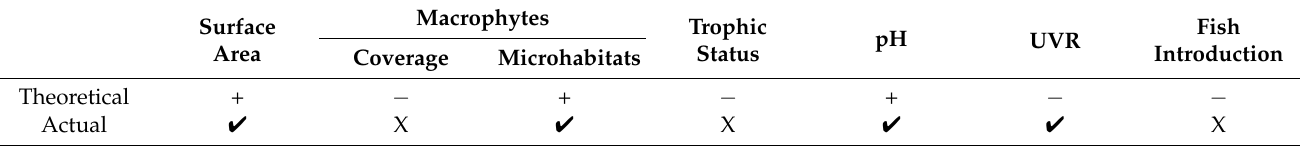
Table 6. Theoretical positive (+) and negative ( − ) effects of the main phytoplankton biodiversity drivers, and actual findings ( (cid:52) match, X no match) of the phytoplankton biodiversity of Lakes El Sol and La